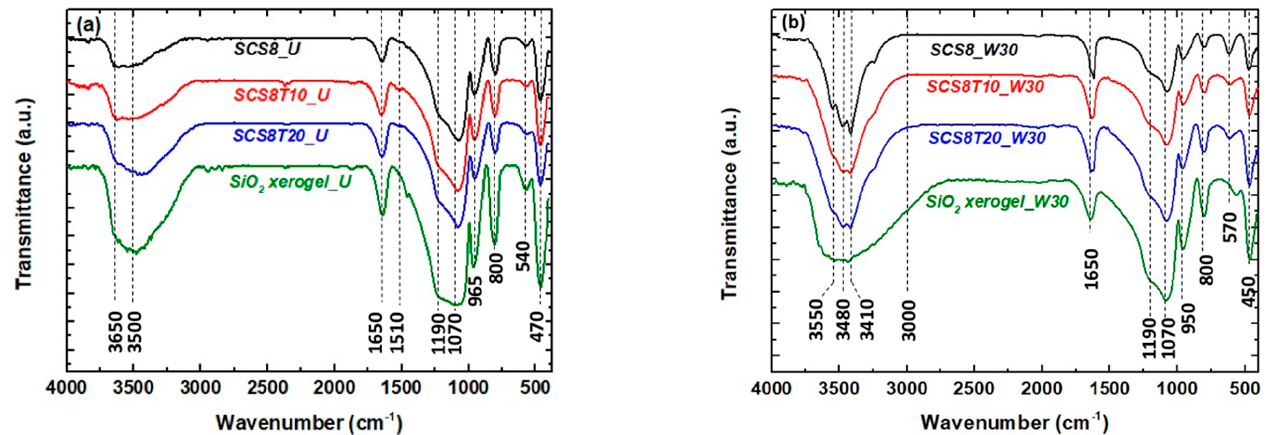
Figure 5. FTIR spectra of SCS8, SCS8T10, SCS8T20, and pure SiO 2 xerogels: ( a ) U; ( b ) W30.